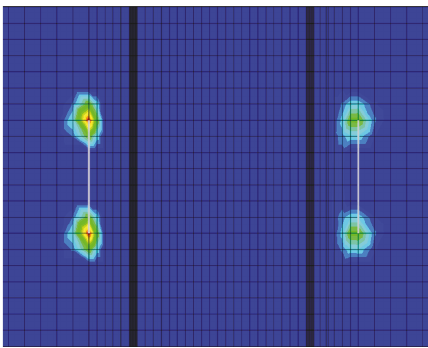
Figure 28: Maximum principal plastic strain of foundation soil- vertical view.